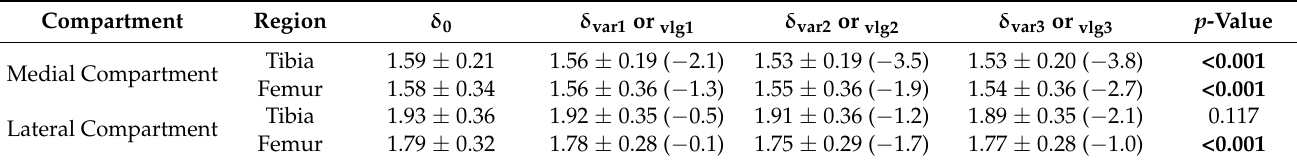
Table 2. Mean absolute thickness of the tibial and femoral articular cartilage regions as a function of loading. Unloaded ( δ 0 ) and loaded to 7.5 kp ( δ var1 , δ vlg1 ), 15 kp ( δ var2 , δ vlg2 ), and 22.5 kp ( δ var3 , δ vlg3 ). Mean ± standard deviations (mm) (mean percentage change versus δ 0 (%)). Values are given for the loaded compartment only, i.e., the medial compartment under varus loading and the lateral compartment under valgus loading. Statistical analysis was performed using repeated measures ANOVA with statistically significant findings highlighted in bold type .